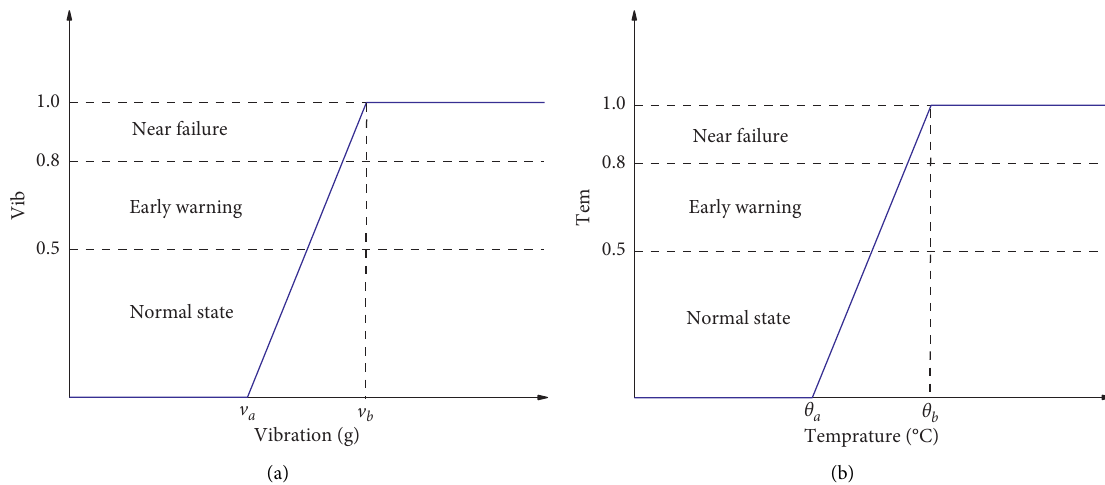
Figure 2: The fuzzy operators of vibration and temperature features. (a) The fuzzy operator of vibration feature. (b) The fuzzy operator of temperature